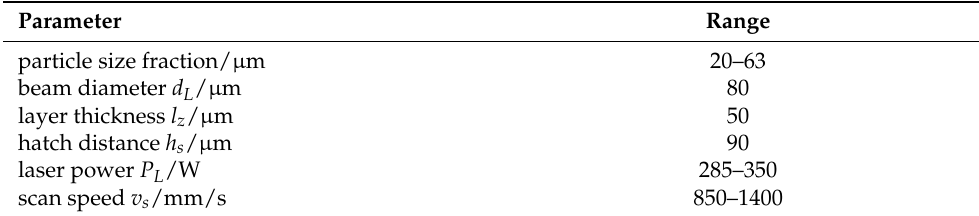
Table 2. Process parameter ranges of LPBF experiments.